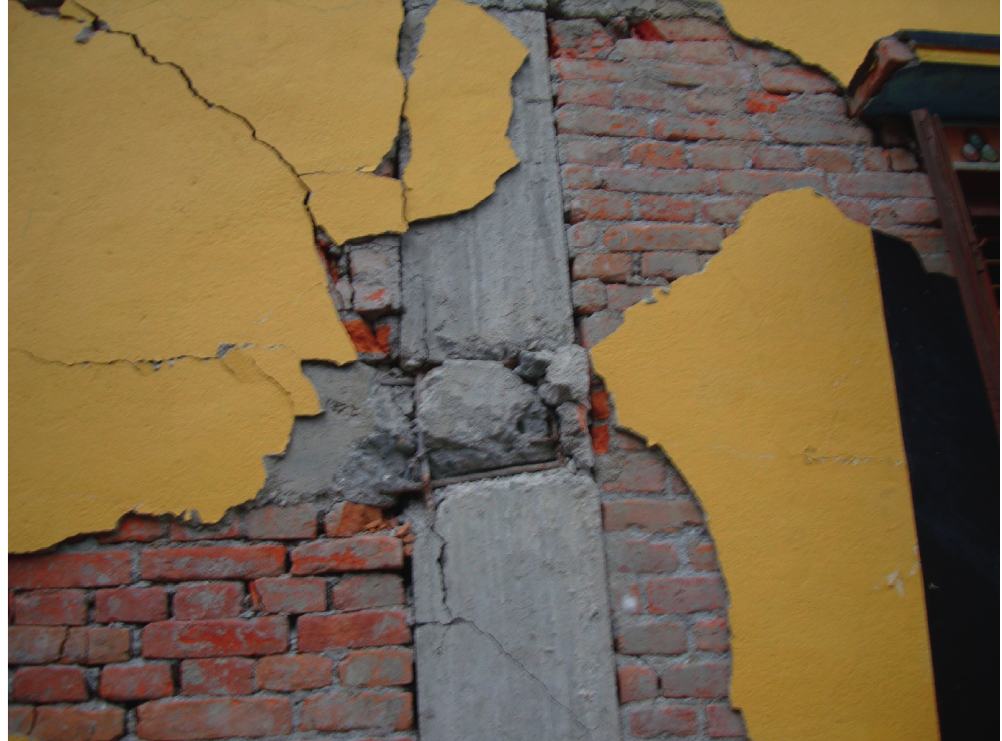
Figure 5: Shear damage of a column at midheight in Kathmandu due to the 2015 Gorkha earthquake.